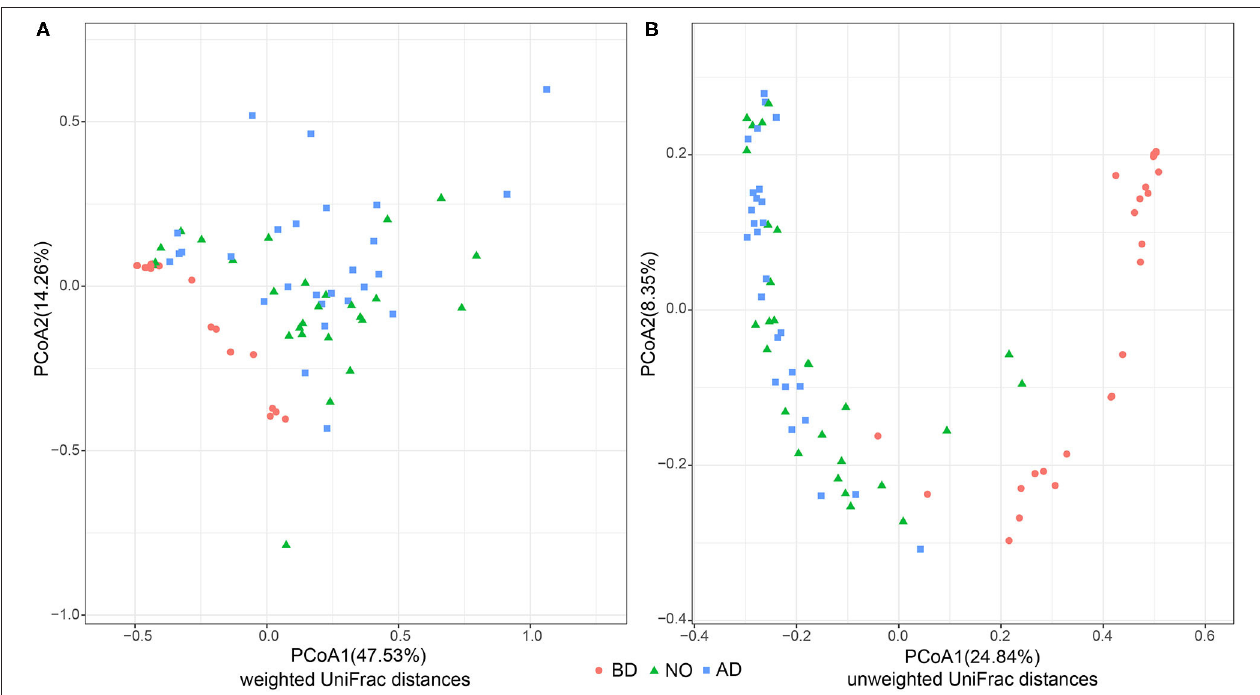
FIGURE 1 | PCoA analysis of three groups based on weighted and unweighted UniFrac distances (group BD, before delivery; group NO, neonatal oral; group AD, after delivery). (A) PCoA analysis performed on weighted UniFrac distances. (B) PCoA analysis performed on unweighted UniFrac distances.